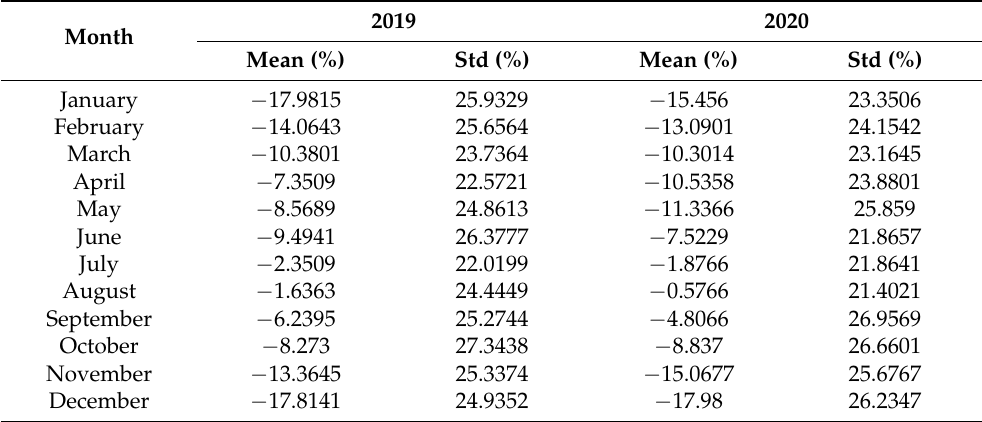
Table 3. The mean biases and standard deviations between HY-2B and CryoSat-2 from January